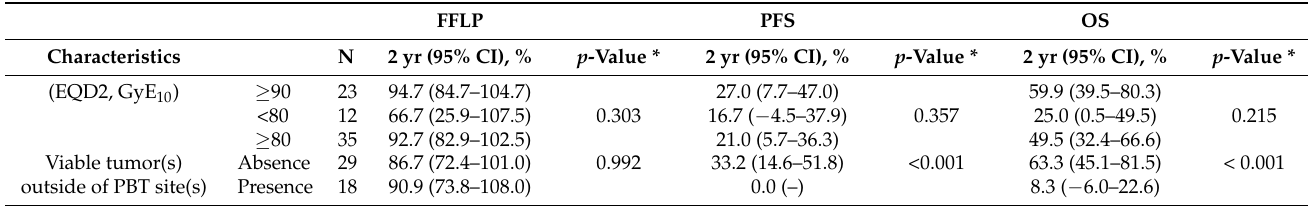
Abbreviations: CI, confidence interval; ECOG PS, Eastern Cooperative Oncology Group performance status; CA 19–9, carbohydrate antigen 19–9; Tx, treatment; PBT, proton beam therapy; CTx, chemotherapy; EQD2, equivalent